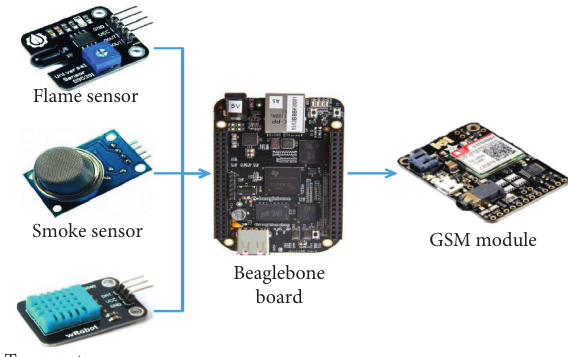
Figure 2: Sensor-based detection unit of the system.